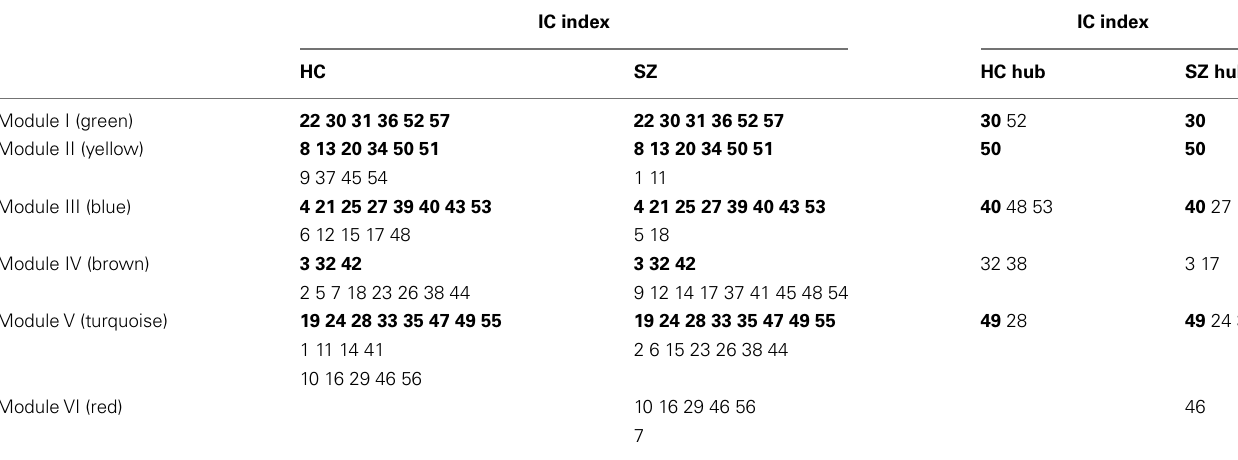
Table 1 | Summary of the modular organization of the group results in HCs and SZs.